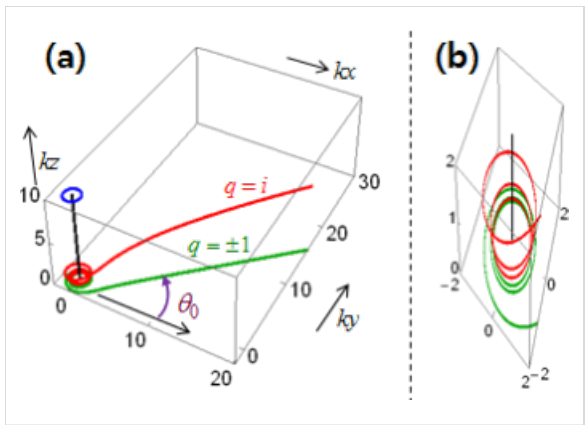
Figure 5: (a) Helical trajectories for the exterior in the ( kx , ky , kz )-space. It is given that R ρ ≡ kR = 1 and m = 3. (b) A zoom-in view around the z